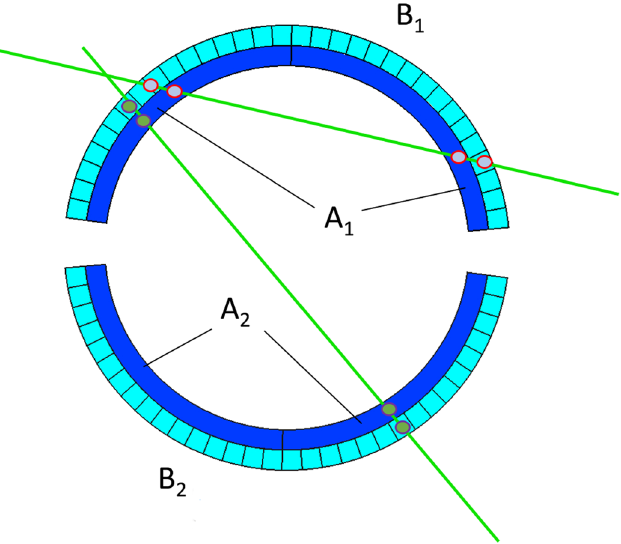
Figure 3. Schematic top view of the detector. The picture shows possible tracks corresponding to the passage of muons.